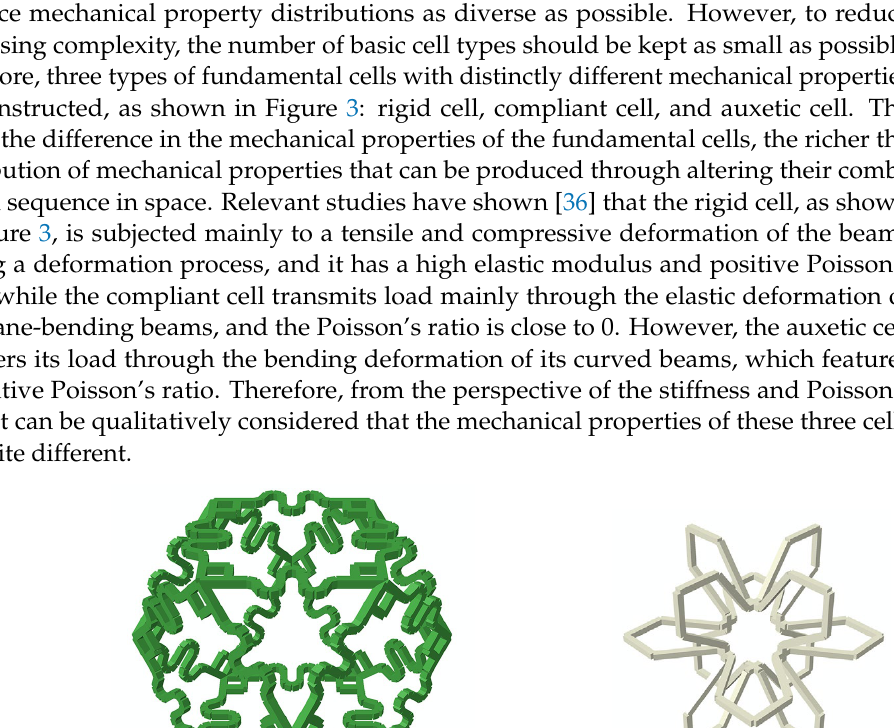
Figure 2. Two-dimensional schematic diagram of the design of the distributed variable thickness structure based on digital metamaterials.